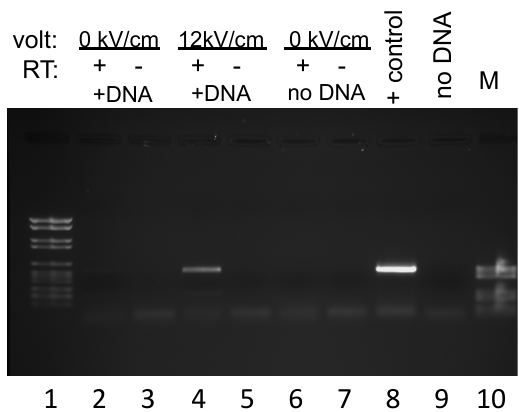
Figure 2. DNA introduced into mitochondria is transcribed: ( A ) Reverse transcription PCR (RT-PCR) products derived from RNA synthesized after incubation of isolated mitochondria with a 847 bp cy3-labeled PCR fragment with (10 kV/cm, 13 kV/cm) or without (0 kV/cm) electroporation. The +RT/ − RT designation indicates reverse transcription reactions done in the presence or absence of enzyme, respectively. Lanes 1 and 10 contain size standards VI and V (Roche), respectively (M); PCR controls are shown in lanes 8 and 9. ( B ) RT-PCR products derived from RNA synthesized after incubation of isolated mitochondria with a 3.9 kb plasmid with (12 kV/cm) or without (0 kV/cm) electroporation. Samples in lanes 6 and 7 demonstrate the lack of background with total mitochondrial RNA (no exogenous DNA, no electroporation) with this set of plasmid-specific PCR primers. Other labels as in